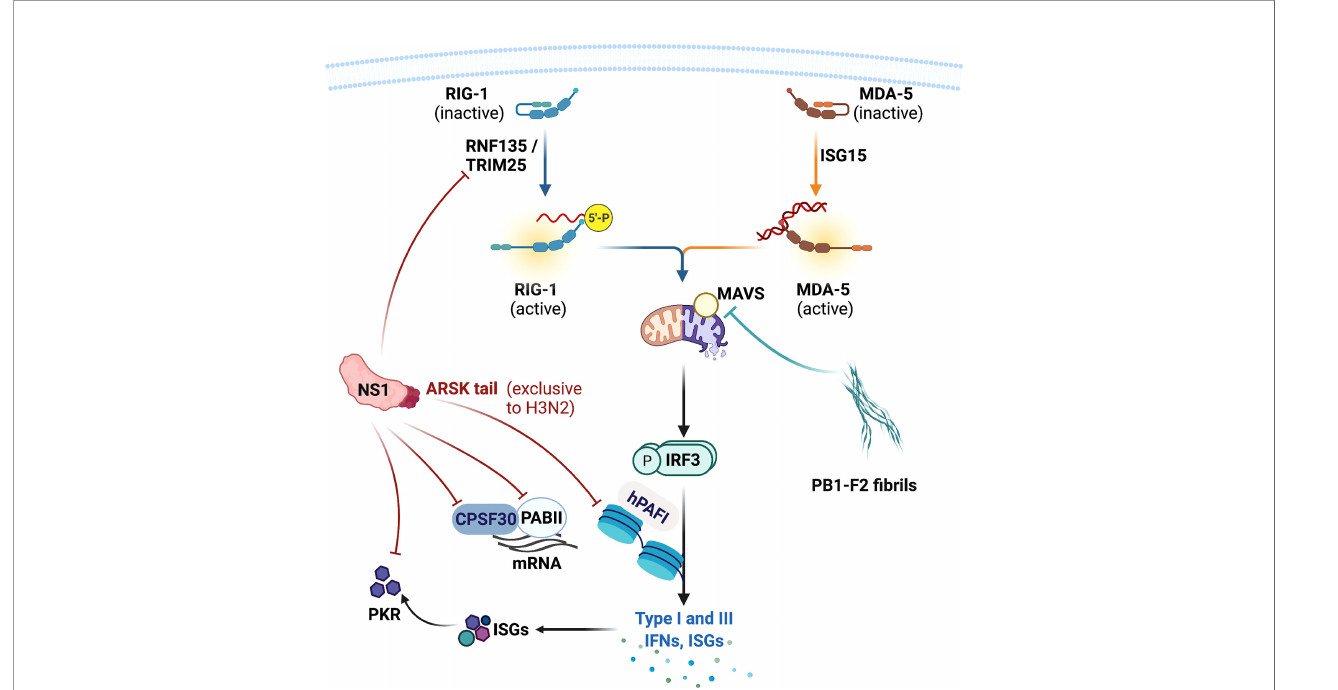
FIGURE 4 | In fl uenza A virus virulence factors and their targets in the host. In fl uenza A viruses produce non-structural (NS)1 and polymerase basic 1 (PB1)-F2 proteins that inhibit host antiviral signalling and responses. NS1 protein impairs the production of type I and III IFNs by directly targeting RIG-I activators RIPLET and TRIM25, and many IFN-stimulated genes (ISGs) including protein kinase R (PKR). NS1 also inhibits host protein synthesis by targeting pre-mRNA cleavage and polyadenylation speci fi city factor 30 (CPSF30) and poly A binding II (PABII) proteins. NS1 also possesses a ARSK tail that inhibits human polymerase II-associated factor 1 (hPAFI) function and host protein transcription. PB1-F2 forms a fi brillar higher-molecular weight aggregate that mainly targets mitochondria and its proteins. PB1-F2 binds with mitochondrial antiviral (MAVS) protein and other mitochondrial membrane proteins, leading to inhibition of type I and III IFN productions and mitochondrial dysfunction. This also results in apoptotic cell death. This fi gure was created with